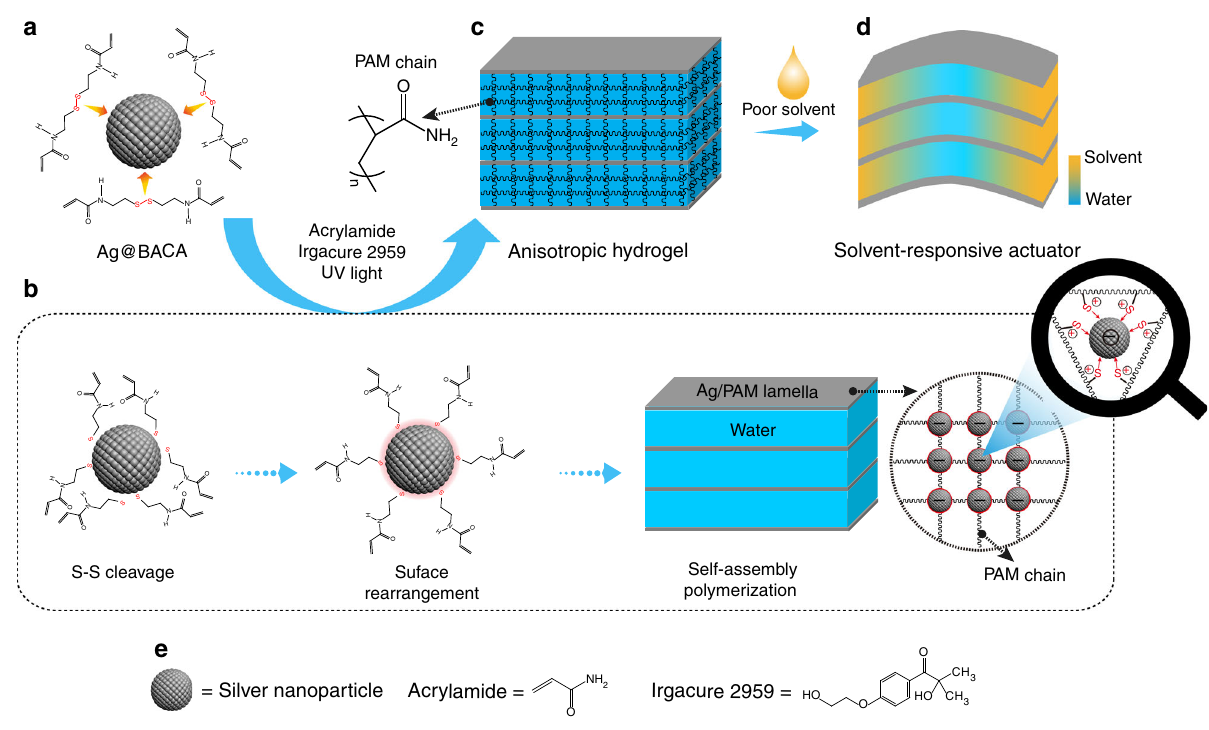
Fig. 1 Schematic illustrations of the formation of SNPP hydrogel. a Ag@BACA nanocomposite linked by the RS-Ag coordination bonds. b When the BACA molecules were adsorbed onto the silver NPs, the S – S cleavage occurred. Under UV light, the cleaved BACA molecules on the surface of silver NPs were rearranged. With the help of the hydrophobically lamellar assembly of the Ag@BACA nanocomposites, the cofacially arranged Ag/PAM lamellae were formed by a UV light induced polymerization. c Upon prolonging the UV irradiation, the anisotropic hydrogel was fabricated by propagating the PAM chains around the Ag/PAM lamellae. d The anisotropic hydrogel shows actuating ability when exposed in poor solvent of PAM chains. e Molecular structure of the used